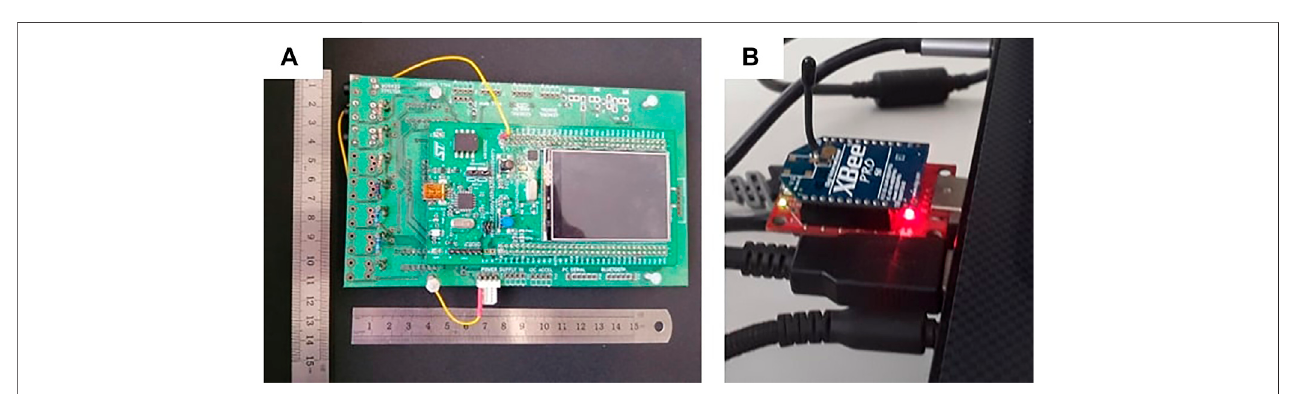
FIGURE 2 | Proposed System Architecture.